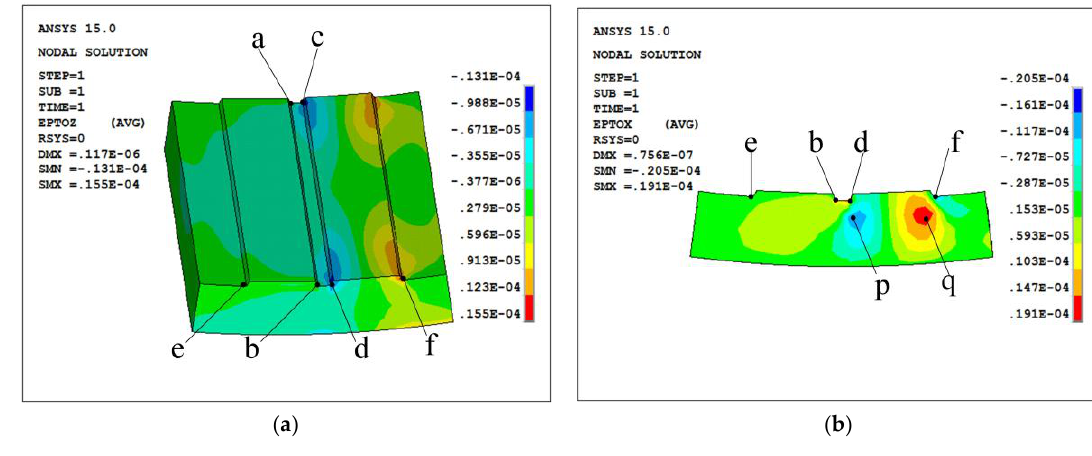
Figure 4. Strain of ( a ) y-direction and ( b ) x-direction.